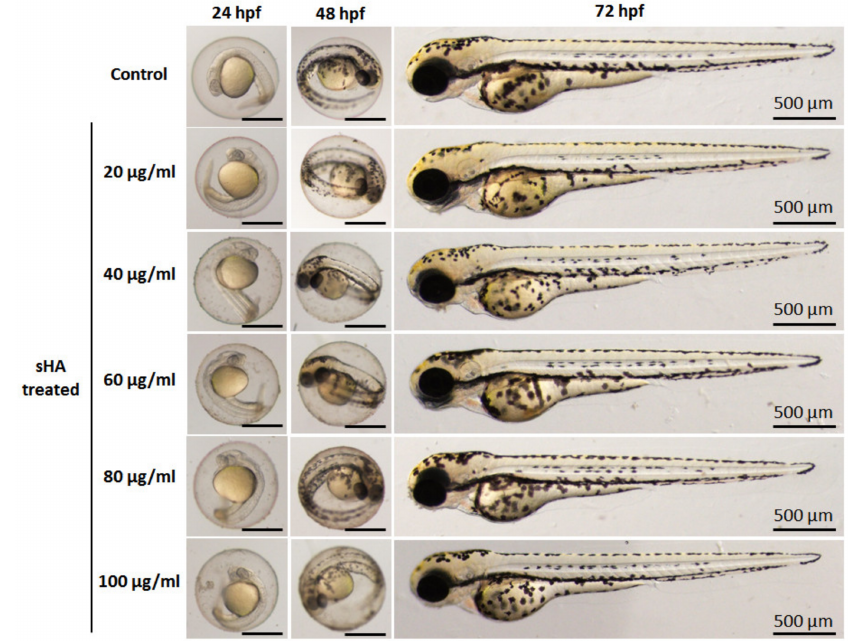
Figure 11. Digital photographs of zebrafish embryos at different stages of growth in solutions exposed to different concentrations ( µ g/mL) of sHA powders at 24, 48, and 72